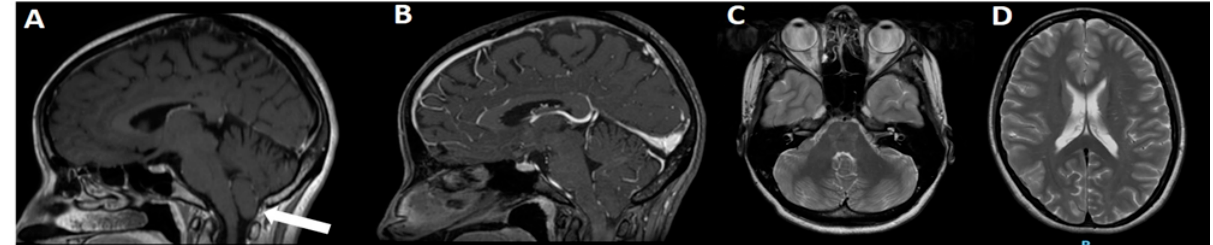
Figure 1. Six-year-old boy with C1M and GTC: ( A ) interictal diffuse spike waves during sleep; ( B ) interictal focal spike waves (fronto-central regions) during sleep.